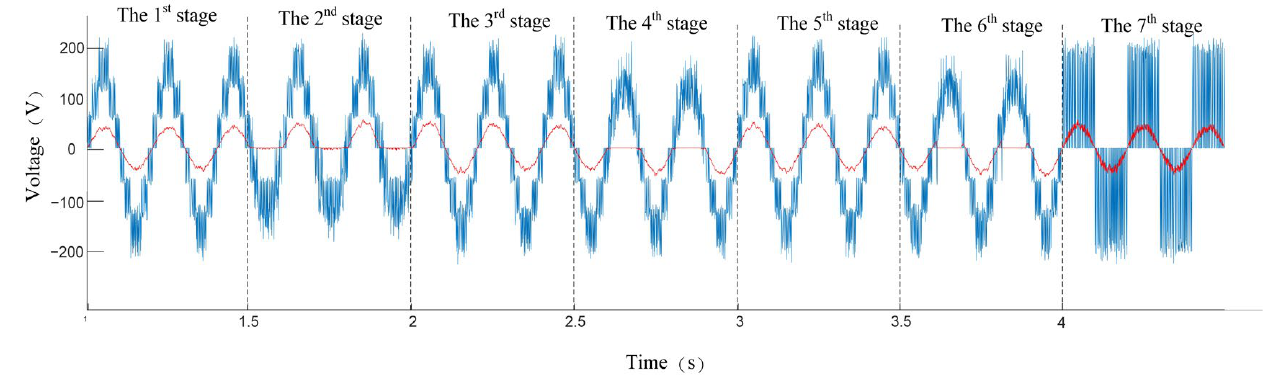
Figure 8. Simulation results of serial fault-tolerant control.